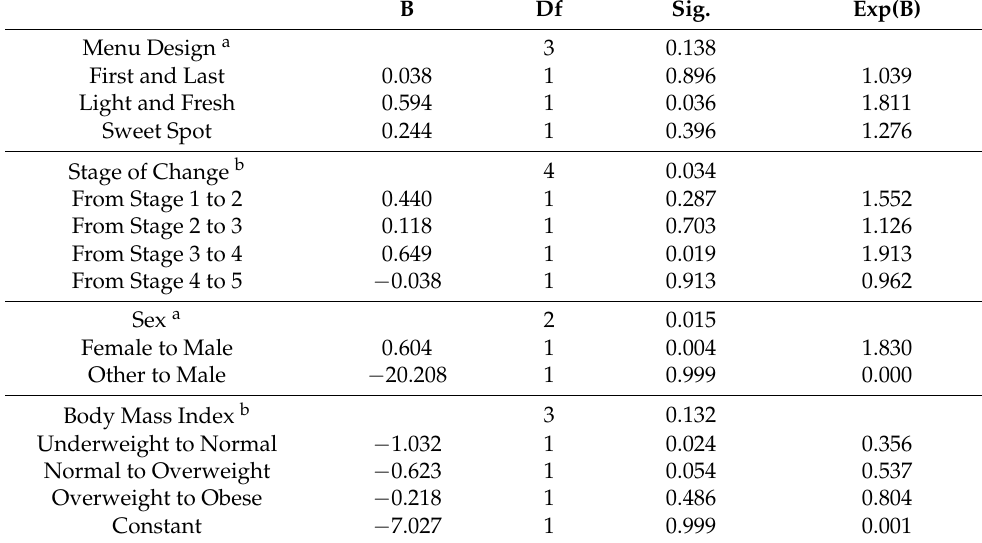
Table 5. Final logistic regression ( n = 471) results from modeling entree calorie choices (< or ≥ 600 calories) using the predictors found to be significant ( p < 0.05): menu design, stage of change, sex, and body mass index